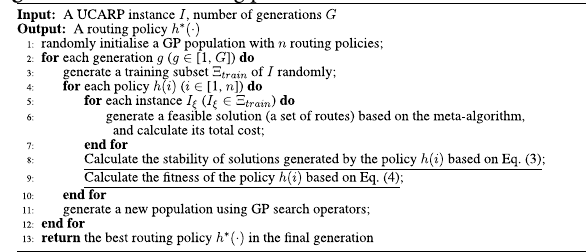
Algorithm 1: The training process of GPHH- α Sta